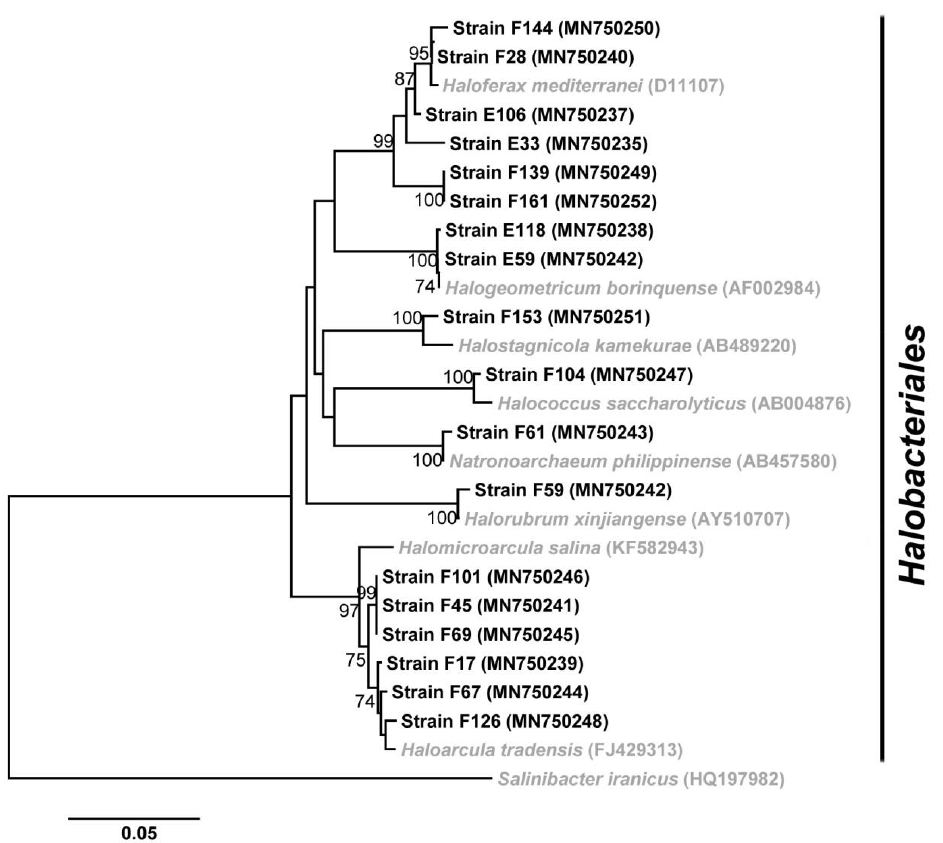
Fig. 3. Phylogenetic inferences based on 16S rRNA gene sequences from isolates belonging to the Archaea domain. The tree is based on the neighbor-joining analysis. The sequence of Salinibacter iranicus used as the outgroup.